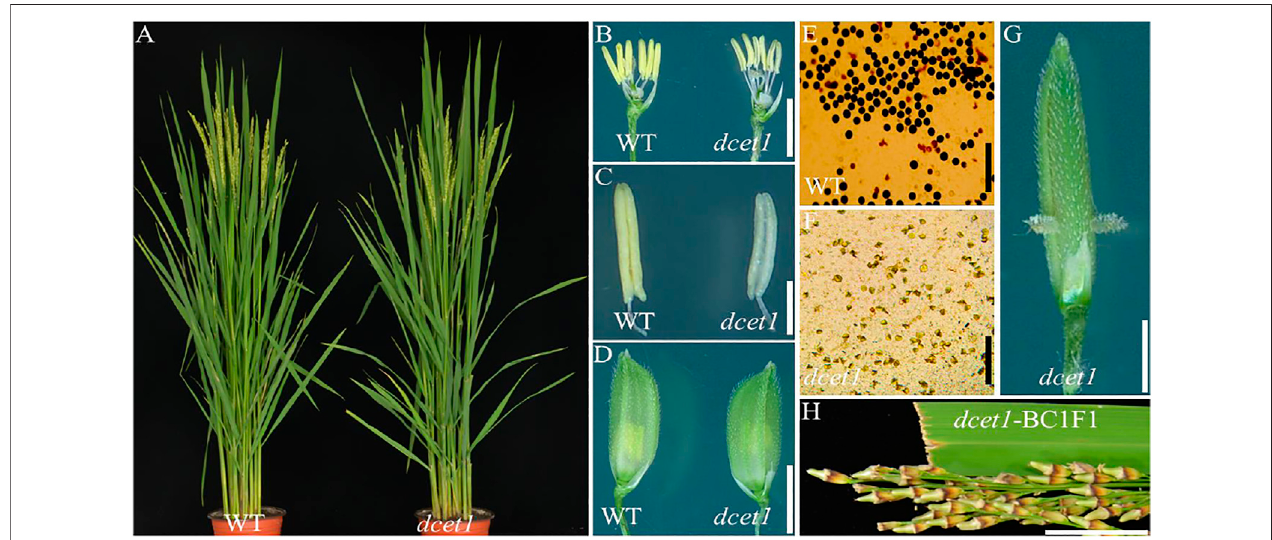
FIGURE 1 | Phenotypic comparison of wild-type (WT) and mutant ( dcet1 ). Plants after heading (A) ; Spikelets after the removal of palea and lemma (B) ; Anthers at stage13 (C) ;Spikeletsattheheadingstage (D) ;Pollengrainsafterstainingwith1.2%I2-KIstainingsolution (E,F) ;Spikeletsof dcet1 withstigmaextrusion (G) ;Panicleof dcet1 -BC1F1 (H) . Scale bars (cid:1) 20 mm in (A) , 1 mm in (B,C) , 2 mm in (D,G) , 100 µm in (E,F) , and 1 cm in (H) .